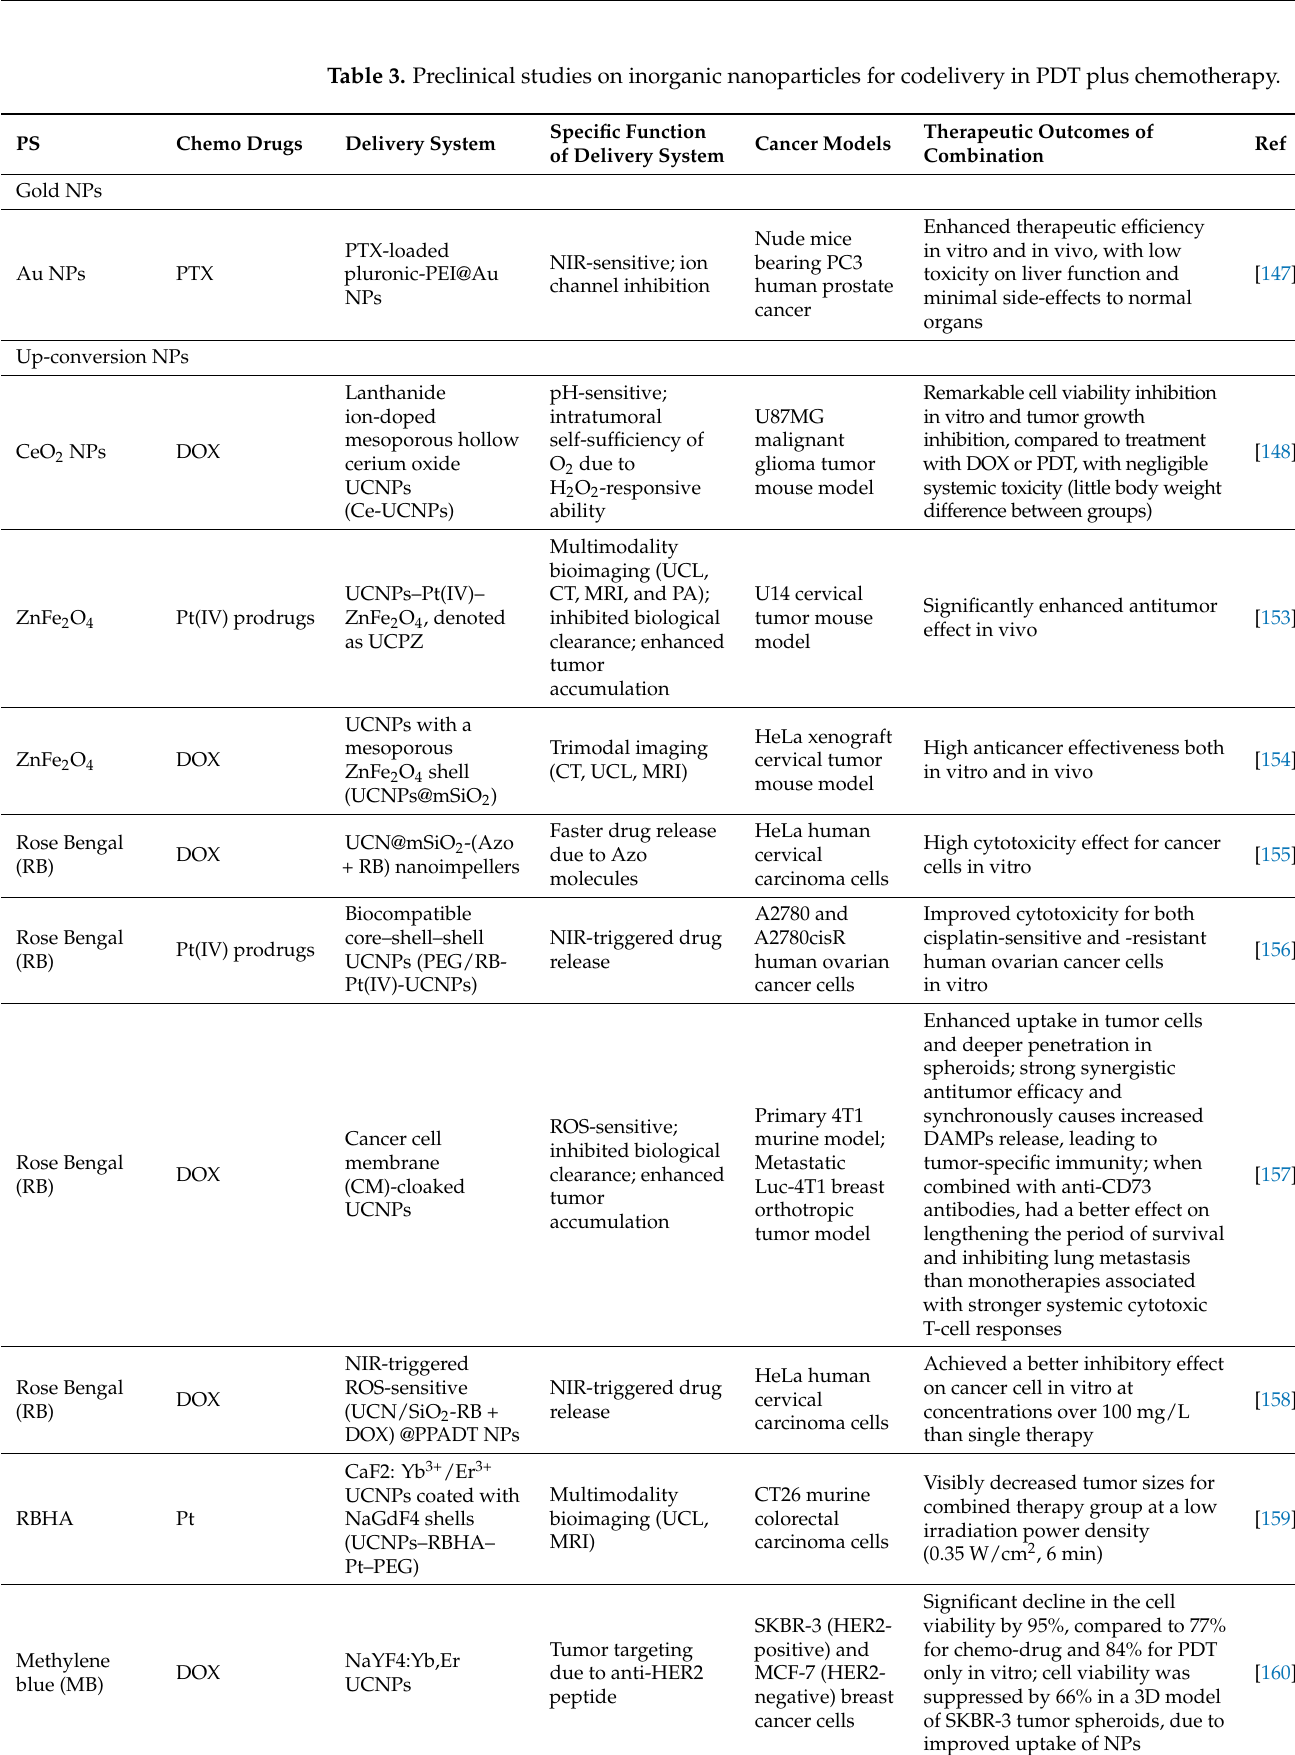
Table 3. Preclinical studies on inorganic nanoparticles for codelivery in PDT plus